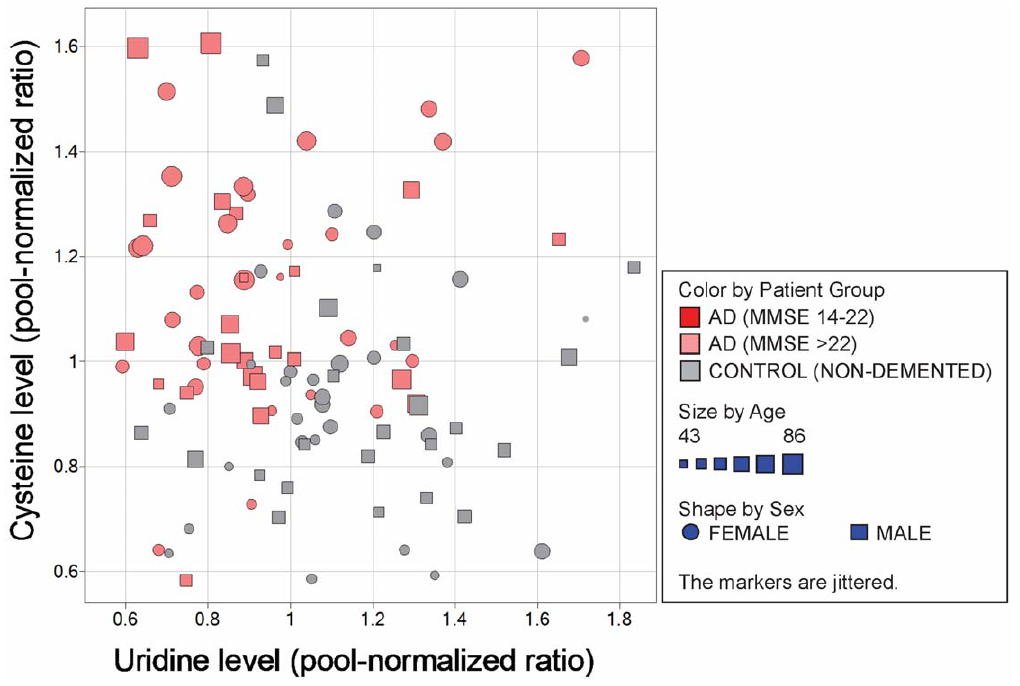
Figure 4. CSF cysteine and uridine levels of patients (females and males) exhibiting light AD (MMSE . 22) compared to healthy controls: , 75% of all samples can be correctly assigned to the respective patient group by using relative ratios for both metabolites.